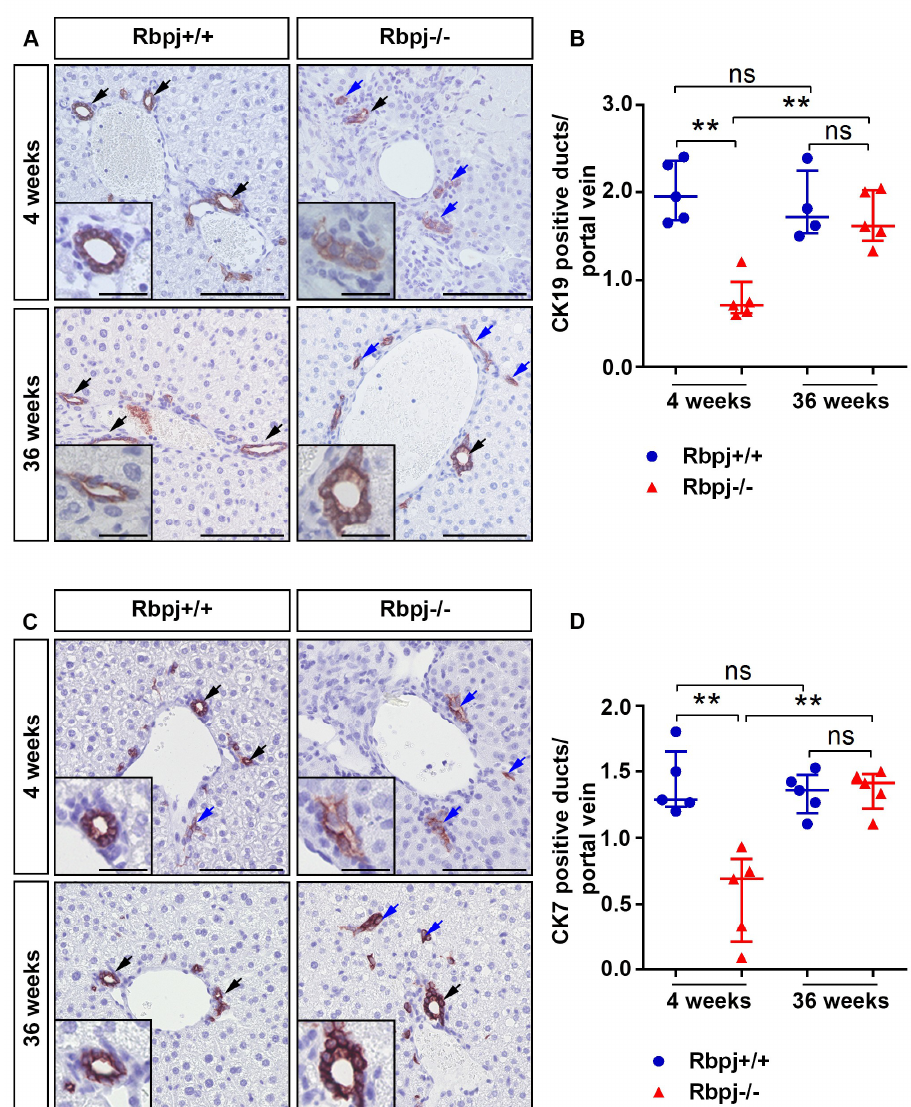
Figure 2. Impaired intrahepatic bile duct development in Rbpj − / − mice. Representative photographs of CK19 ( A ) and CK7 ( C ) immunostaining performed on liver sections of 4- and 36-week-old mice. Four-week-old Rbpj − / − liver exhibit formation of immature, scattered bile duct structures; there are some clusters of CK19/CK7 positive cells without a clear lumen or dispersed single CK19/CK7 positive cells (blue arrow). In contrast, 36-week-old Rbpj − / − liver has a combination of matured CK19/CK7 positive bile duct structures (black arrow) and persisting irregular CK19/CK7 positive clusters (blue arrow) ( n = 5; scale bar: 100 µ m (inlets (A+C) represents a high magnification of a duct structure from the corresponding figure, scale bar: 25 µ m)). Scatter dot plots shows CK19 ( B ) and CK7 ( D ) positive lumen structures per portal vein ( n = 5; ** p ≤ 0.01, ns = not significant; Mann–Whitney test (Two tailed)).